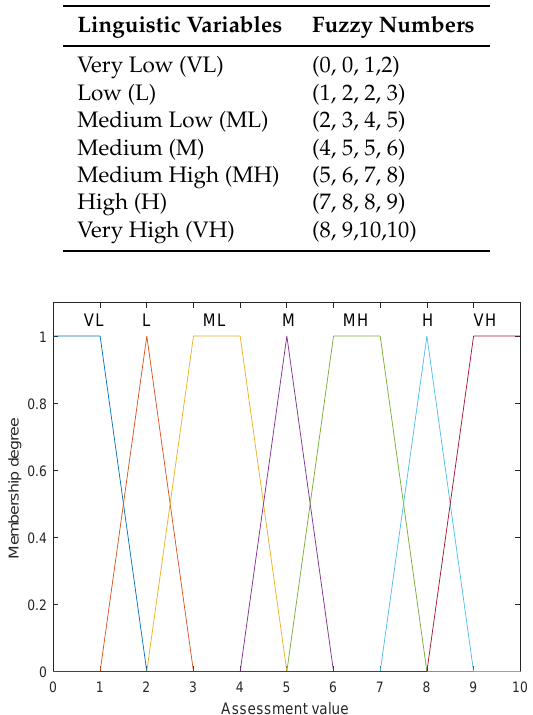
Figure 2. Graphically presentation of fuzzy linguistic variables in Table